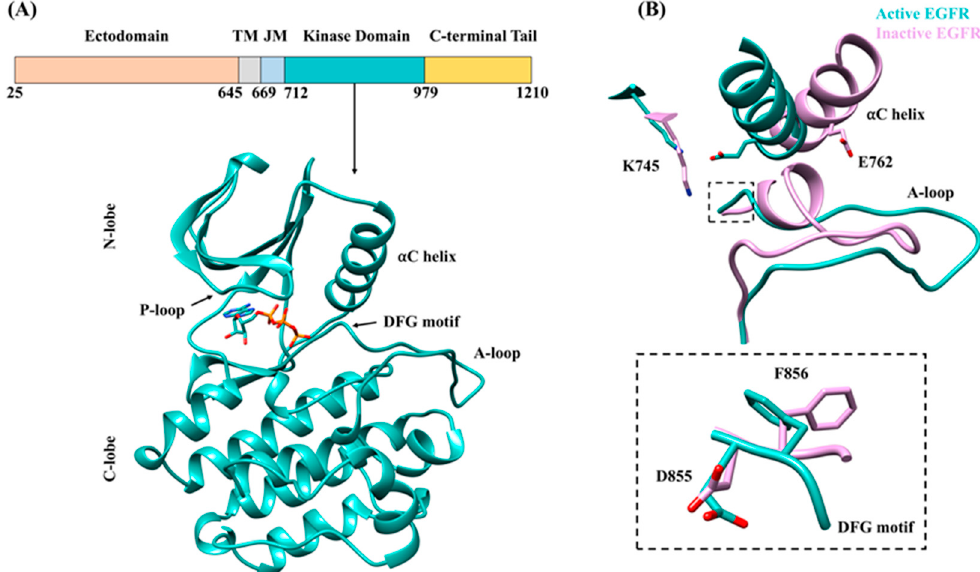
Figure 1. Epidermal growth factor receptor (EGFR) and structural features of the tyrosine kinase domain. ( A ) The different domains that make up the EGFR protein and structure of the intracellular kinase domain (Protein Data Bank (PDB) ID 2GS2 [10]); key structural elements and active site-bound ATP are highlighted. ATP was positioned based on AMP-PNP bound EGFR structure (PDB ID 2ITX [11]). ( B ) The active (cyan) and inactive (purple) conformations of the EGFR kinase domain as seen by comparing PDB ID 2GS2 with PDB ID 2GS7 [10]: the “ α C-in” and “ α C-out” conformations of the α C helix, the open and extended state of the activation loop (A-loop), the essential K745–E762 ionic interaction broken in the inactive state, and conformational differences within the aspartate–phenylalanine–glycine (DFG) motif.